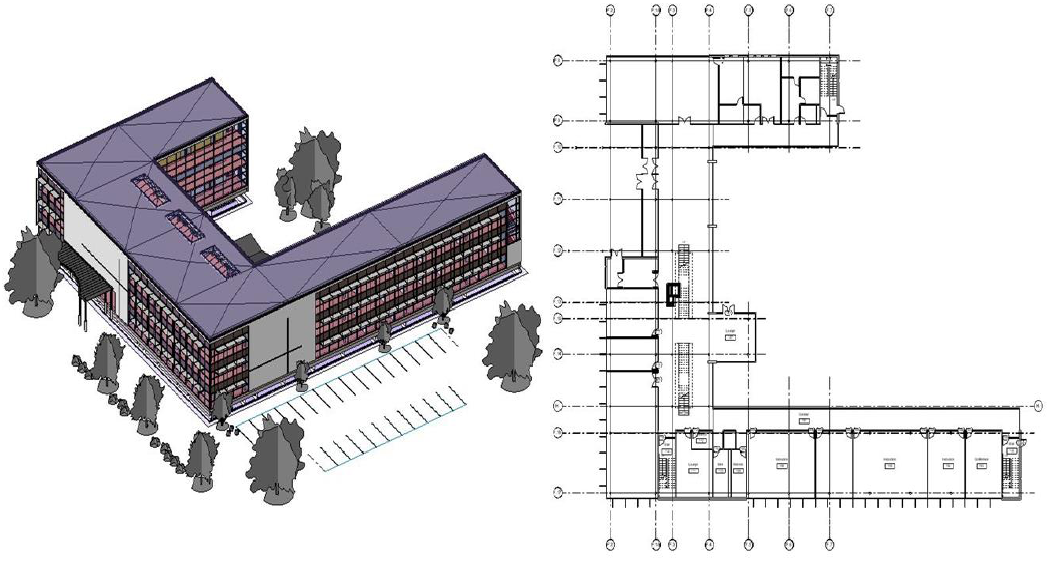
Figure 4. Isometric view and plan of Sample Project.